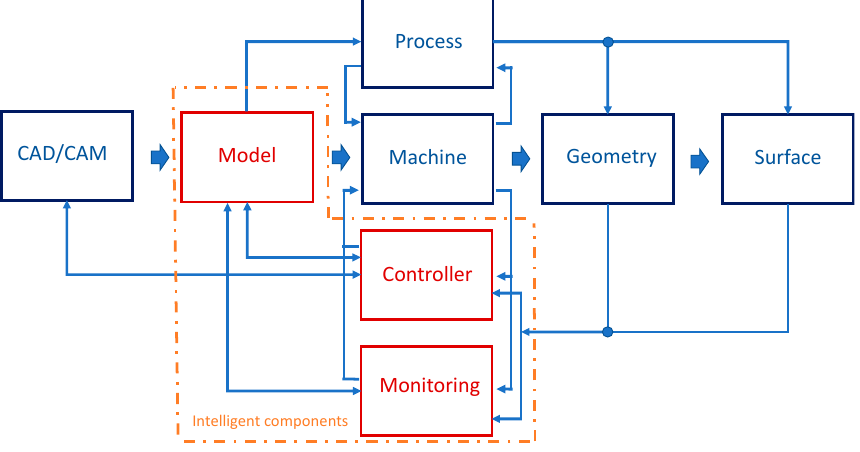
Figure 8. Self-optimizing manufacturing machine [104].